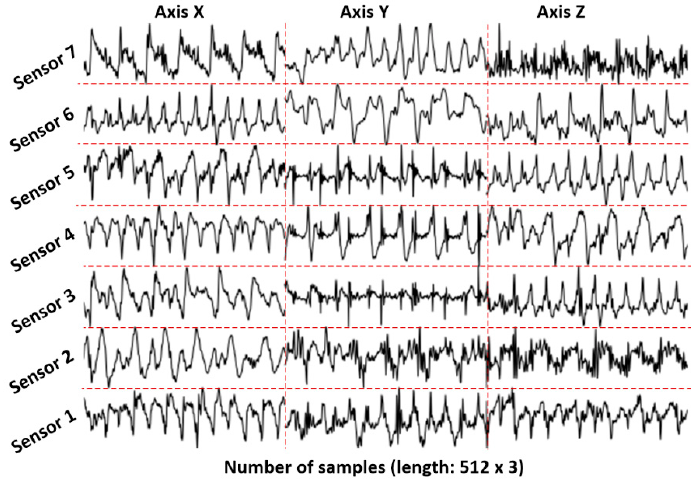
Figure 2. Raw acceleration plot of time domain: segment length 512 and sampling rate 50 Hz (the dotted lines are added manually for better clarification; image resolution is 512 × 512 pixels).